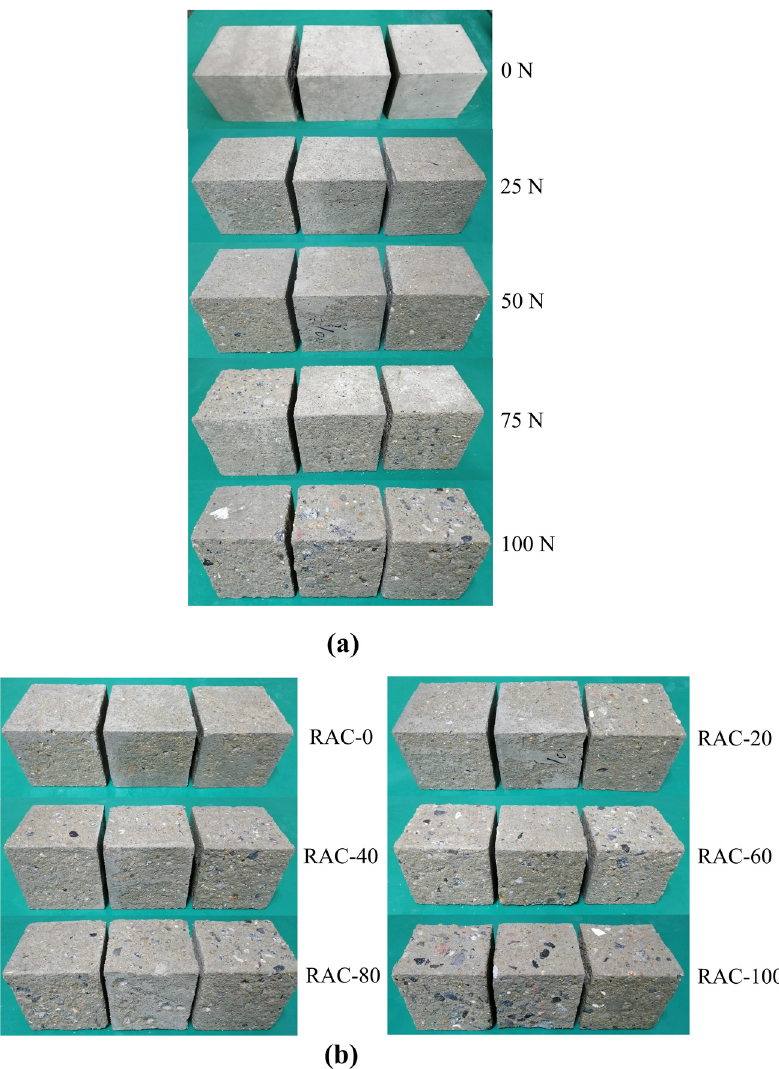
Figure 4: Damage morphology of specimens after salt - frost cycles: ( a ) RAC - 60 and ( b )